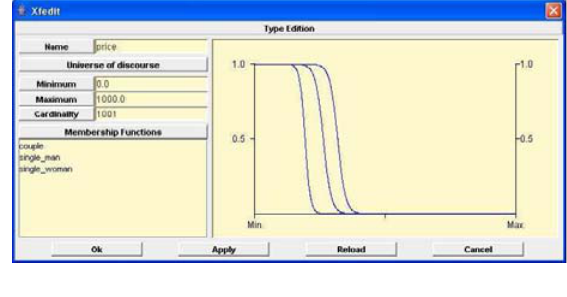
Fig. 8: Output variable price in Xfuzzy